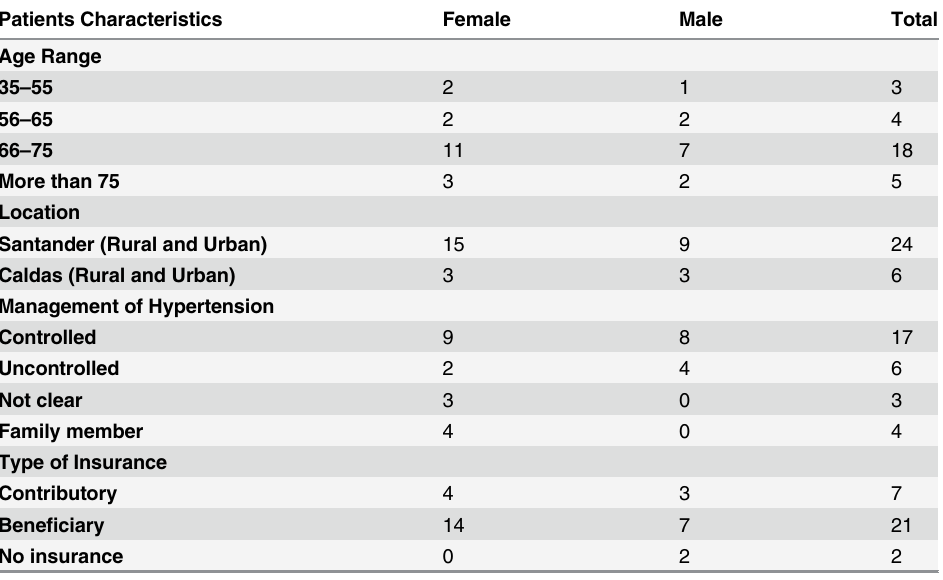
Table 1. Patients ’ and family members ’